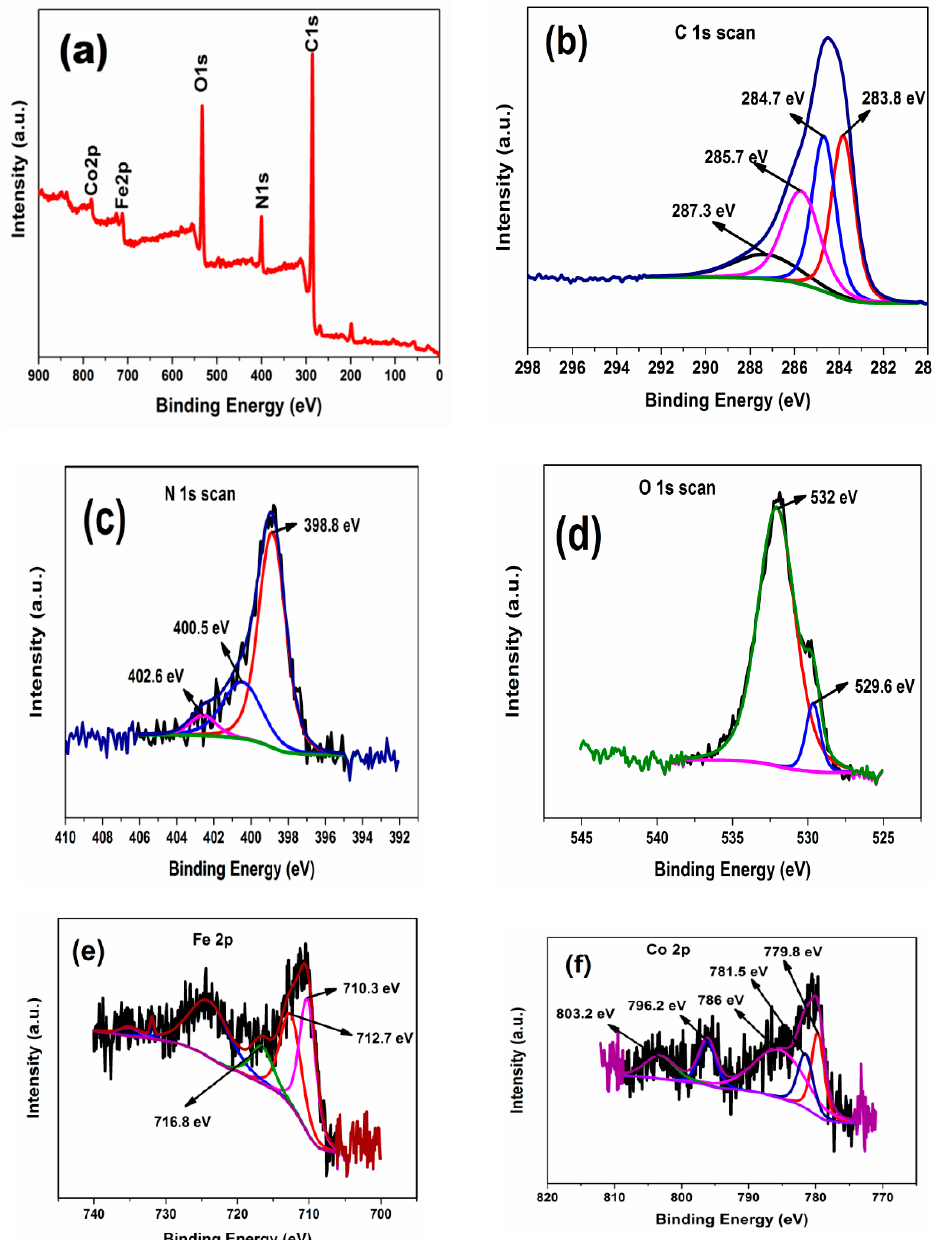
Figure 11. XPS of PAni-CoFe 2 O 4 (50%) nanocomposite: ( a ) survey spectra, ( b ) C1s spectra, ( c ) N1s spectra, ( d ) O1s spectra, ( e ) Fe 2p, ( f ) Co 2p.